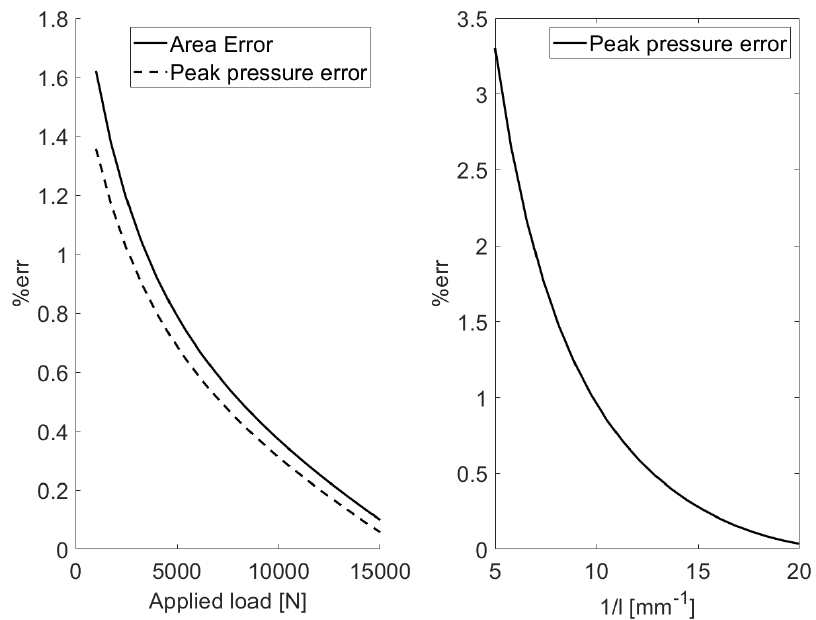
Figure 7. Ellipsoid–ellipsoid contact percent error versus Hertz’s theory.